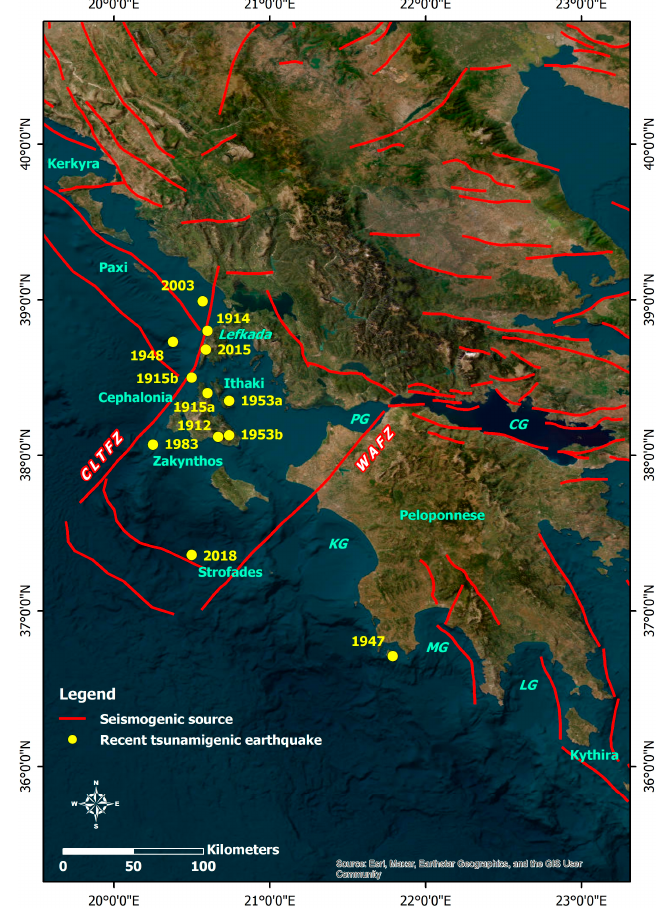
Figure 7. Spatial distribution of epicenters and occurrence dates of the recent tsunamigenic earth- quakes in the Ionian Sea and the offshore western and southern Peloponnese [35,37,160] along with their seismogenic sources. The central part of the study area is dominated by fault zones which accommodate right-lateral strike-slip deformation. The strike-slip Cephalonia–Lefkada Transform Fault Zone (CLTFZ) and the Western Achaia Fault Zone (WAFZ) are both responsible for the generation of large and destructive strike-slip earthquakes. PG: Patras Gulf; CG: Corinth Gulf; KG: Kyparissia Gulf; MG: Messenian Gulf; LG: Laconian Gulf. The faults are derived from the Greek Database of Seismogenic Sources (GreDaSS) compiled by Caputo and Pavlides [36], while the parameters of the presented earthquakes are presented in Table 2.